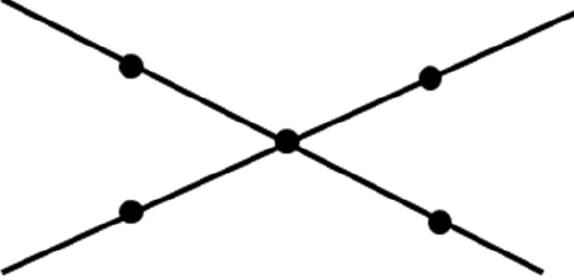
Figure 1. Diagram of the “X” transect.